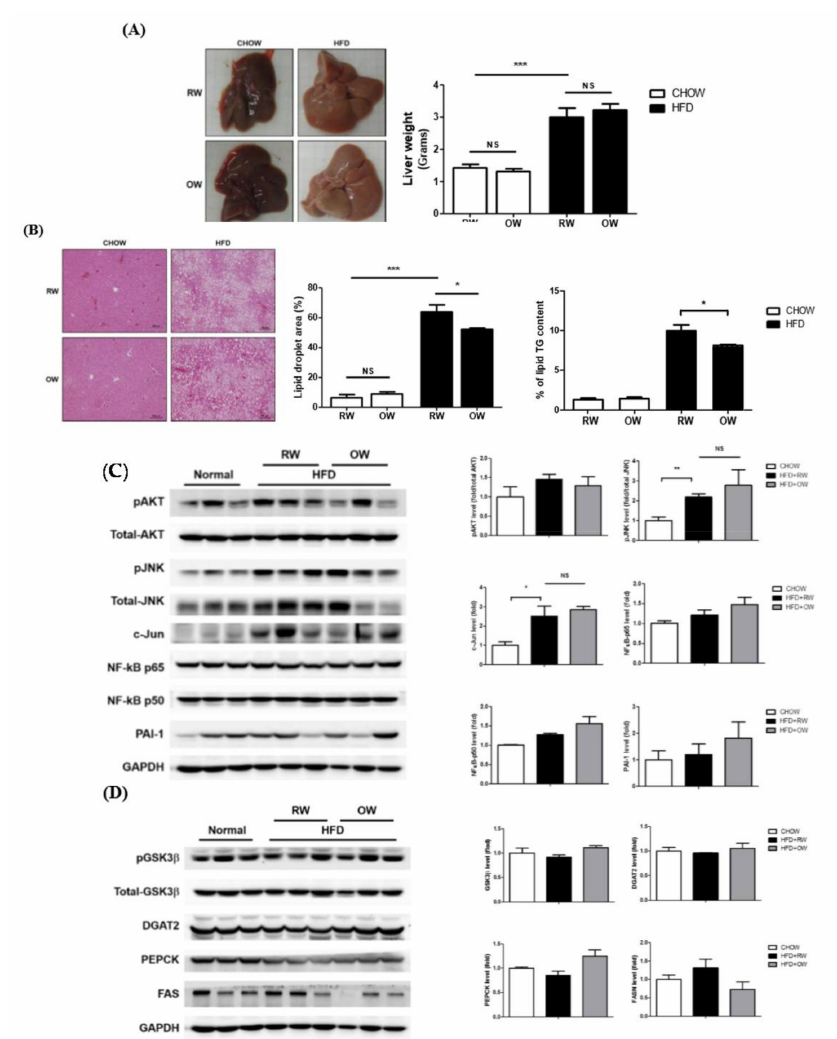
Figure 7. Long-term oxygenated water consumption ameliorates hepatic steatosis. C57BL / 6J mice were fed with CHOW or HFD and either OW or RW as drinking water. ( A ) Liver weights were measured at the end of study. ( B ) Hepatic contents of lipid and triglyceride (TG) were determined as detailed in Methods, scale bar: 100 µ m. Levels of hepatic pro-inflammatory molecules and pAKT ( C ) as well as major proteins in involved in energy metabolism ( D ) were analyzed and quantified. Data were presented as mean ± S.E.M, and statistically analyzed by two-tail unpaired Student t -test; * p < 0.05, ** p < 0.01, *** p < 0.001, NS: no